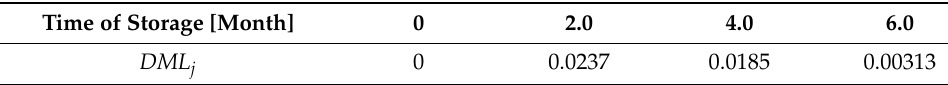
Table 1. DML j after 2, 4 and 6 months of storage.